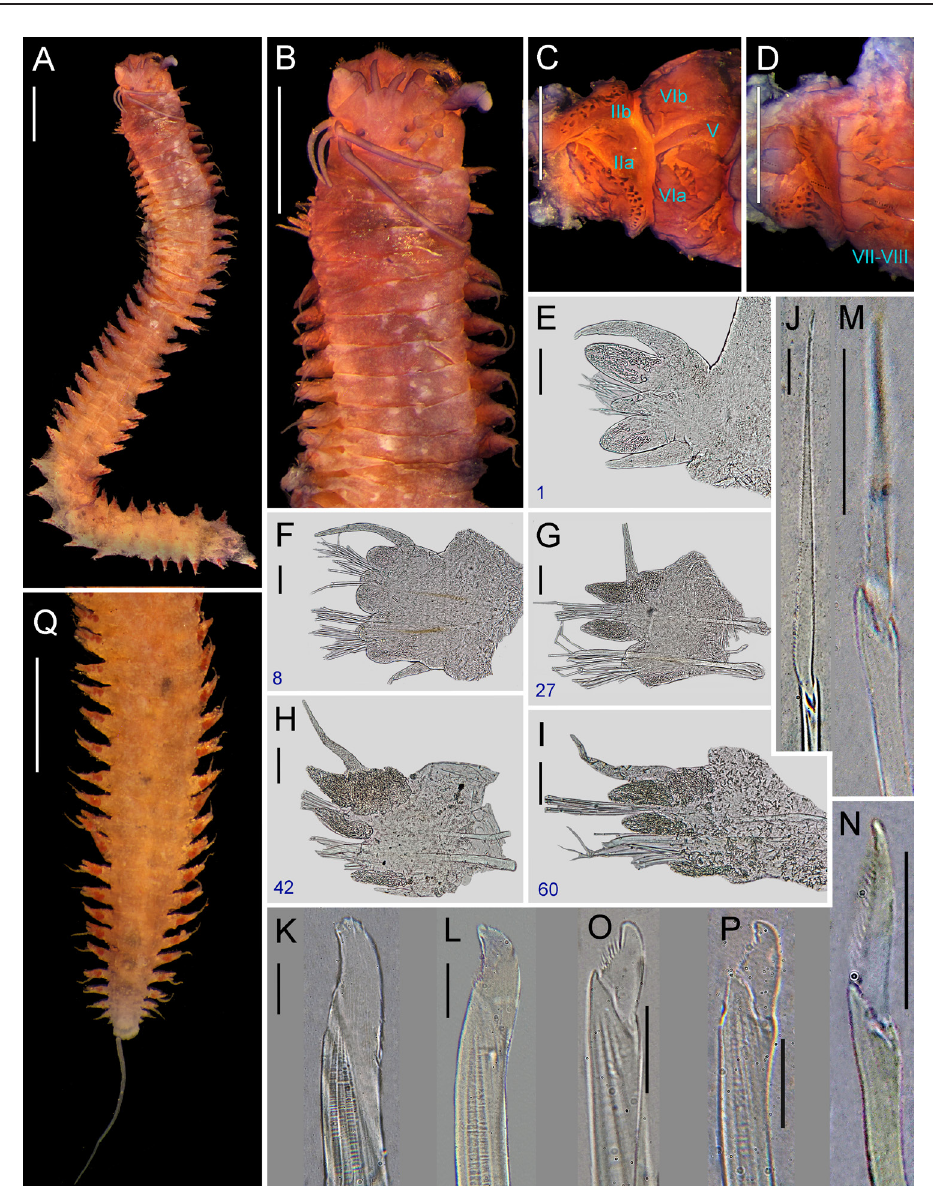
Fig. 3. Neanthes helenae Kinberg, 1865. A–B, E–Q . Complete syntype (SMNH Type-457) from Jamestown, St Helena Island, atokous. C–D . Incomplete syntype (SMNH Type-457) from Jamestown, St Helena Island, atokous. A . Entire body in dorsal view. B . Anterior end in dorsal view. C . Everted pharynx in dorsal view. D . Everted pharynx in ventral view. E . Right parapodium from chaetiger 1 in anterior view with ventral cirri missing. F . Right parapodium from chaetiger 8 in anterior view. G . Right parapodium from chaetiger 27 in anterior view. H . Right parapodium from chaetiger 42 in anterior view with ventral cirri missing. I . Right parapodium from chaetiger 60 in anterior view. J . Homogomph spiniger from notochaetae (chaetiger 27). K . Heterogomph spiniger from subacicular neurochaetae (chaetiger 1). L . Heterogomph falciger from subacicular neurochaetae (chaetiger 1). M . Heterogomph, fused falciger from supracicular neurochaetae (chaetiger 42). N . Heterogomph falciger from supracicular neurochaetae (chaetiger 60). O. Heterogomph falciger from subacicular neurochaetae (chaetiger 13). P . Heterogomph falciger from subacicular neurochaetae (chaetiger 60). Q . Posterior end in dorsal view. A–D, Q: stained with Shirlastain A. Roman numerals refer to the areas and Arabic numbers to chaetigers. Scale bars: A–B = 1 mm; C–D, Q = 0.5 mm; E–I = 0.1 mm; J–P = 20